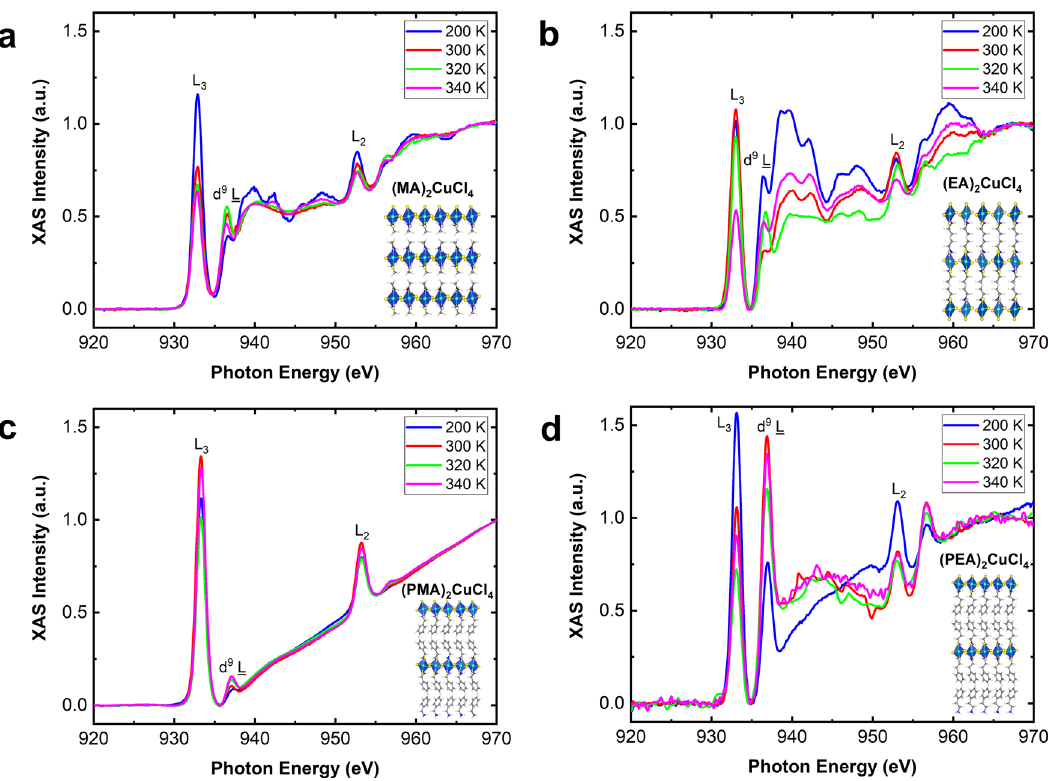
Fig. 1 Temperature-dependent XAS spectra of Cu L 2,3 edge in different A 2 CuCl 4 compounds. Inset represent each of the optimized geometrical structure. a (MA) 2 CuCl 4 absorption L -edge pro fi le, indicating the coexistence of L 2 and L 3 absorption peak accompanied by the presence of d 9 L and d 9 signals. b (EA) 2 CuCl 4 absorption L -edge with a pronounced spectral weight transfer. c (PMA) 2 CuCl 4 absorption L -edge with strong suppression as the higher spectral feature are diminished. d (PEA) 2 CuCl 4 absorption L -edge are depicted the L 3 and d 9 L competing interaction within the elevated temperatures. The temperature data represent 200 K (blue), 300 K (red), green (320 K), and magenta (340 K)